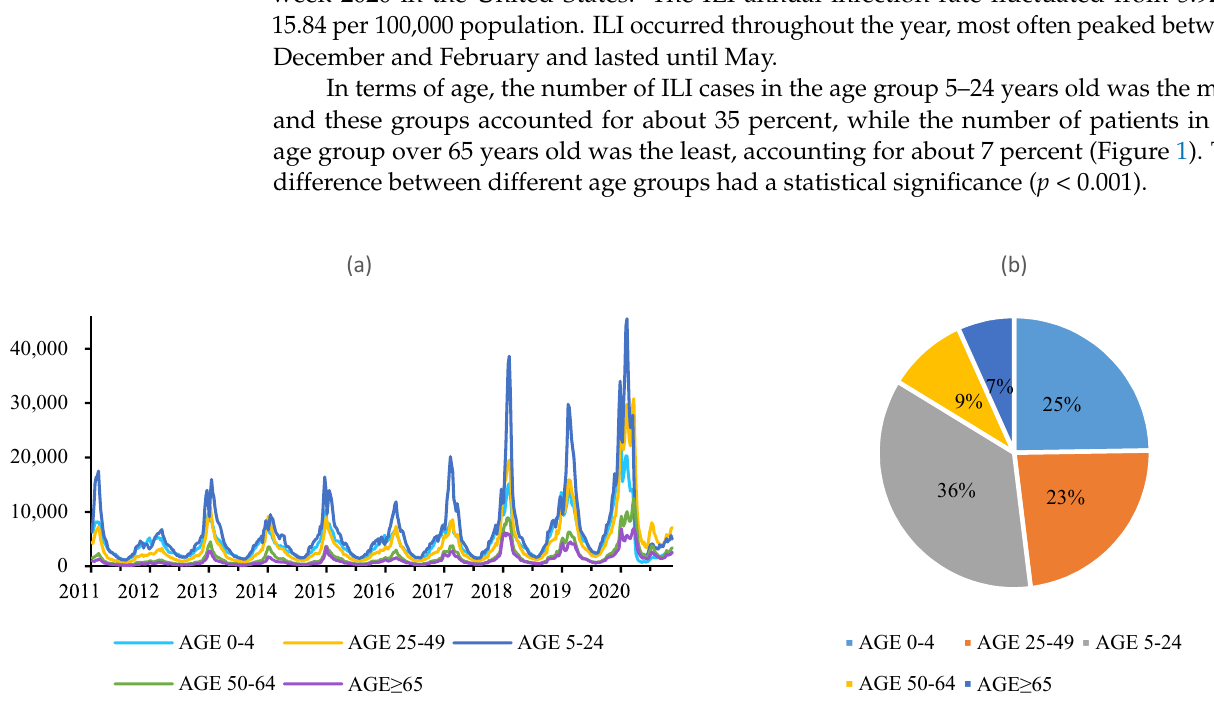
Figure 1. Epidemiological characteristics of influenza and ILI in the United States from 1st week 2011 to 29th week 2020. ( a ) Weekly ILI cases of different age, ( b ) age distribution of ILI. This study collected the population of 49 states and visualized them on the map (Figure 2), and found no obvious association between population density and influenza inci-